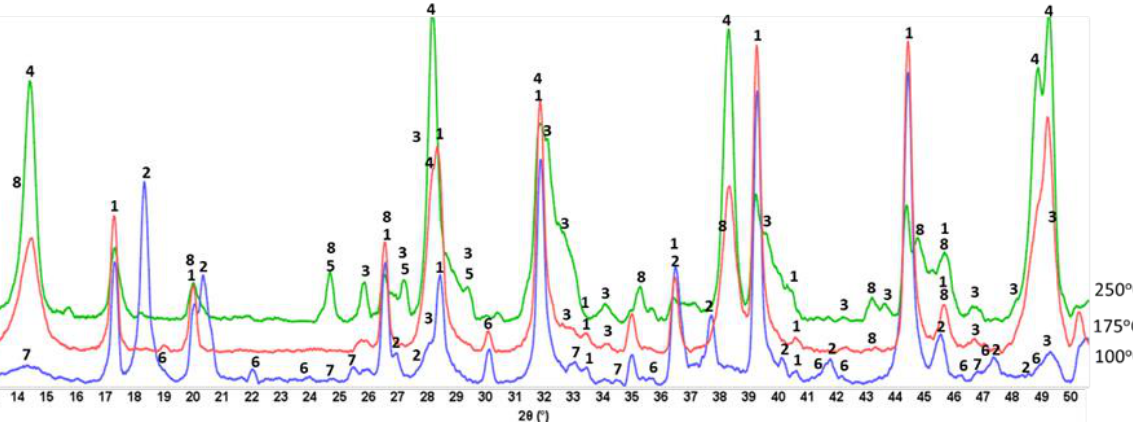
Figure 18. XRD patterns for 100-, 175-, and 250 ◦ C-autoclaved CaP/MGF cements: 1-katoite (00- 024-0217/01-077-0240/01-084-01354/01-074-9779); 2-gibbsite (01-076-1782); 3-hydroxyapatite (04- 016-1647/04-011-6221/01-074-9779); 4-boehmite (04-010-5683); 5-calcium carbonate (01-085-6719); 6-krotite (00-023-1037); 7-grossite (00-023-1037); and 8-hydrosodalite